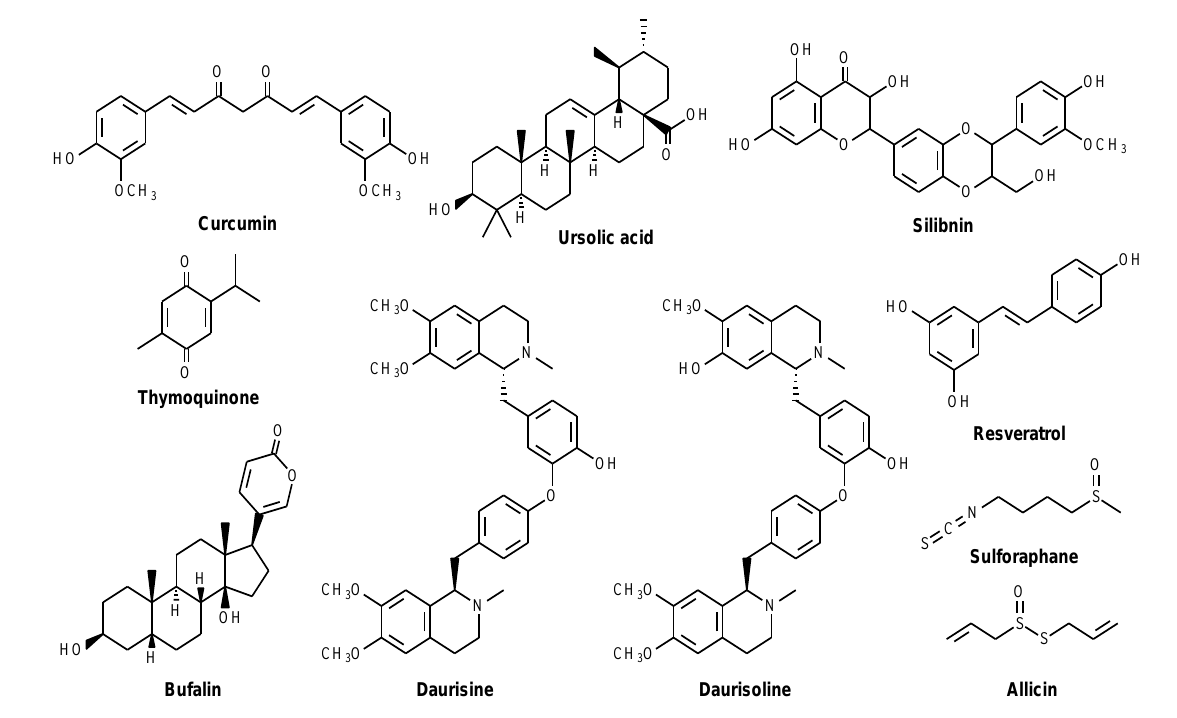
Figure 2. Structures of the natural compounds for the treatment of colorectal cancer by targeting the autophagy pathway.